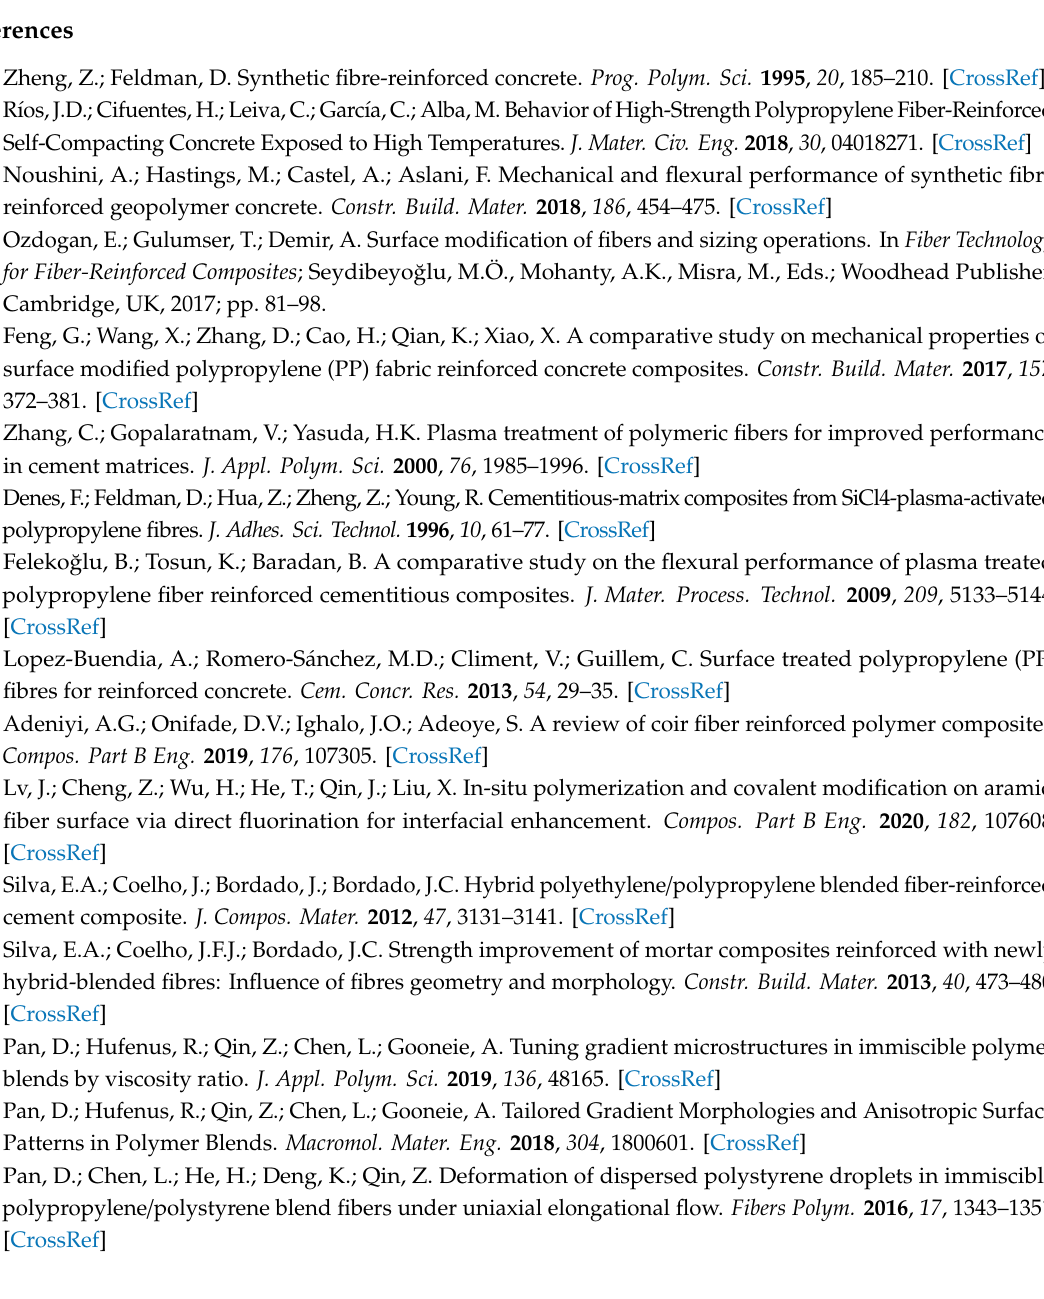
Figure S1: The shear viscosities of polymers as a function of time at 250 ◦ C, Figure S2: The shear viscosities of polymer blends as a function of shear rate at 250 ◦ C, Table S1: The reaction recipe of suspension polymerization of PS, Table S2: Fitted parameters of the three-parameter Bird-Carreau model for PS / PP